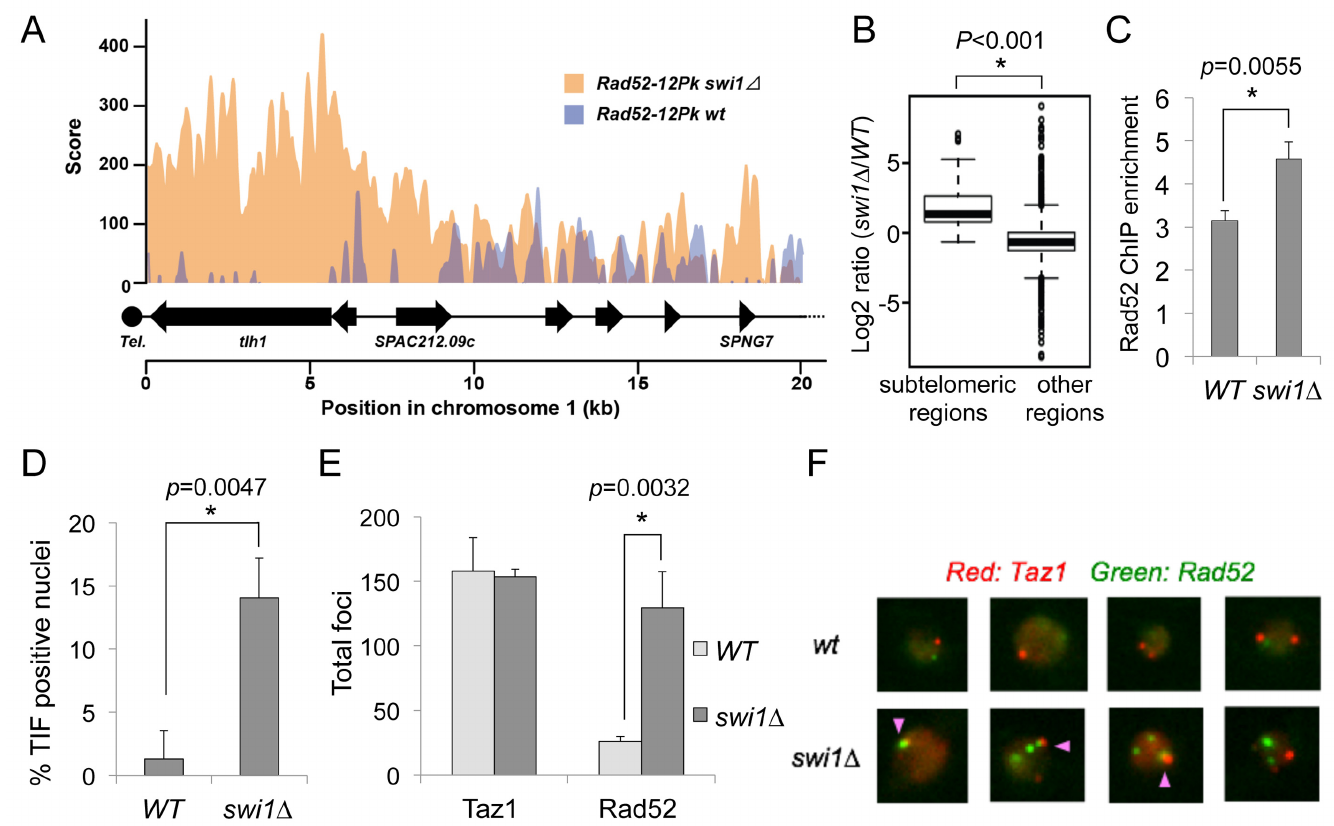
Fig 1. Swi1 loss causes DNA damage at telomeres. (A) Genome-wide (ChIP-seq) analysis of Rad52 distribution at the subtelomeres (left arm of chromosome 1) in asynchronous cultures of wild-type (green) and swi1 Δ (blue) cells. Enrichment of Rad52 is displayed as enrichment scores (y-axis). Chromosome coordinates [x-axis, in megabases, (Mb)] were downloaded from the S . pombe Genome Project (Sanger Center: www.sanger.ac.uk/Projects/ S_pombe). The strains used for our experiments are both heterothallic h + strains. (B) Box plots for log2 ratios of Rad52 enrichment at subtelomeric regions vs other regions. The boxes were limited by the 25th and 75th percentiles, with the black lines representing the median ratios between swi1 Δ and wild-type. The whiskers are extended out to the most extreme data points that are at most 1.5 times the interquartile range from the box. The black circles represent outliers. The p -value was evaluated by Mann-Whitney U test. (C) ChIP assays showing Rad52 enrichment at telomeres in wild-type and swi1 Δ cells. Rad52-12Pk was immunoprecipitated from the indicated cells, and associated DNA was subjected to competitive multiplex PCR to amplify DNA fragments from the TAS1 region and a gene-free region (GFR2), which was used as an internal amplification control. Chromatin association of Rad52-12Pk at TAS1 was presented as relative enrichment over the association at GFR2. Data are expressed as the mean of three independent experiments. Error bars represent the standard deviation. p -value was determined by two-tailed Student's t-test. (D-E-F) Wild-type and swi1 Δ cells expressing Rad52-YFP and Taz1-mCherry were grown in minimal medium at 25°C until mid-log phase. Nuclei (n = 102) were analyzed for the percentage of TIF-positive nuclei in (D) as well as for the total number of Rad52-YFP and Taz1-mCherry foci in (E). Accumulation of Rad52-YFP foci (E) and a significant increase in TIF-positive nuclei were observed in the swi1 Δ cells (D). Data shown is the mean of three independent experiments. Error bars represent the standard deviation. p -values were determined by two-tailed Student's t-test. (F) Representative microscopic images. Pink arrows indicate